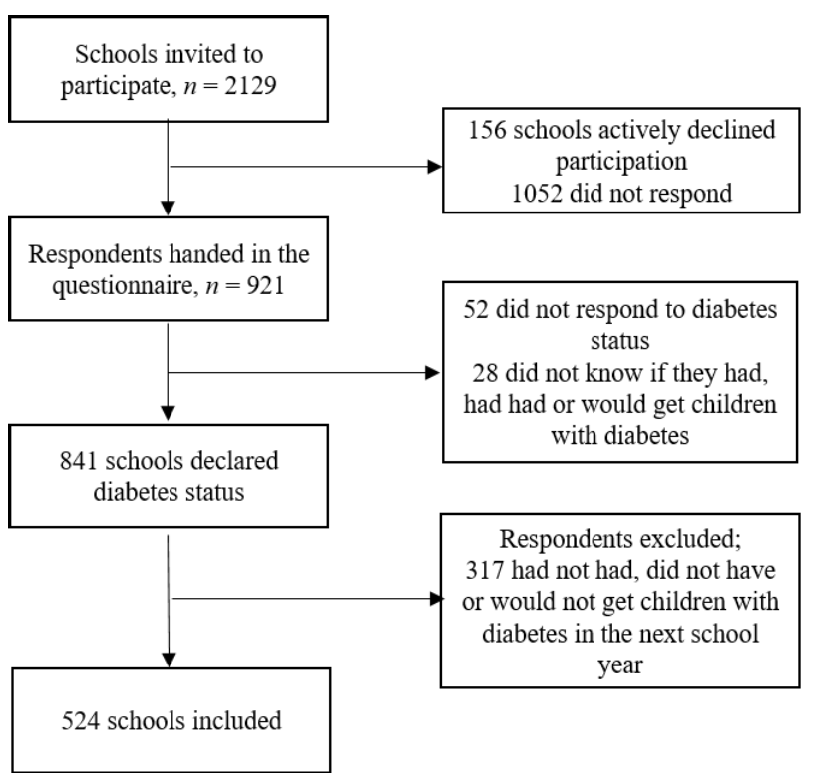
Figure 1. Flowchart of the inclusion into the study.